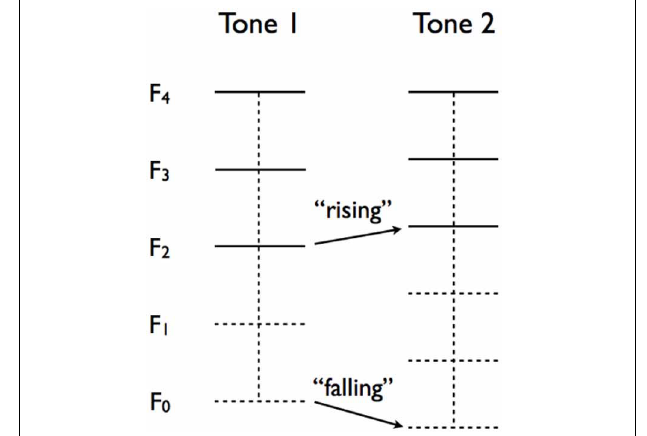
FIGURE 1 | Illustration of an ambiguous two-tone sequence to determine auditory perception bias. The sequence has a falling (missing) fundamental F 0 and a rising lowest partial F lp The horizontal lines represents the partials of the tone. The higher partials are physically present (solid lines) and the lower partials are missing (dashed